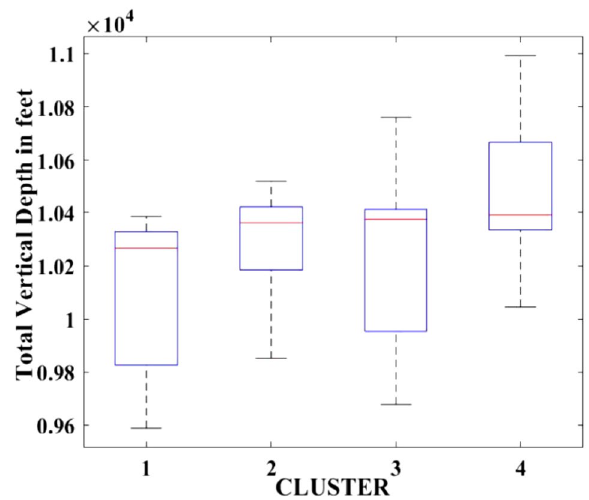
Figure 9. Total vertical depth.